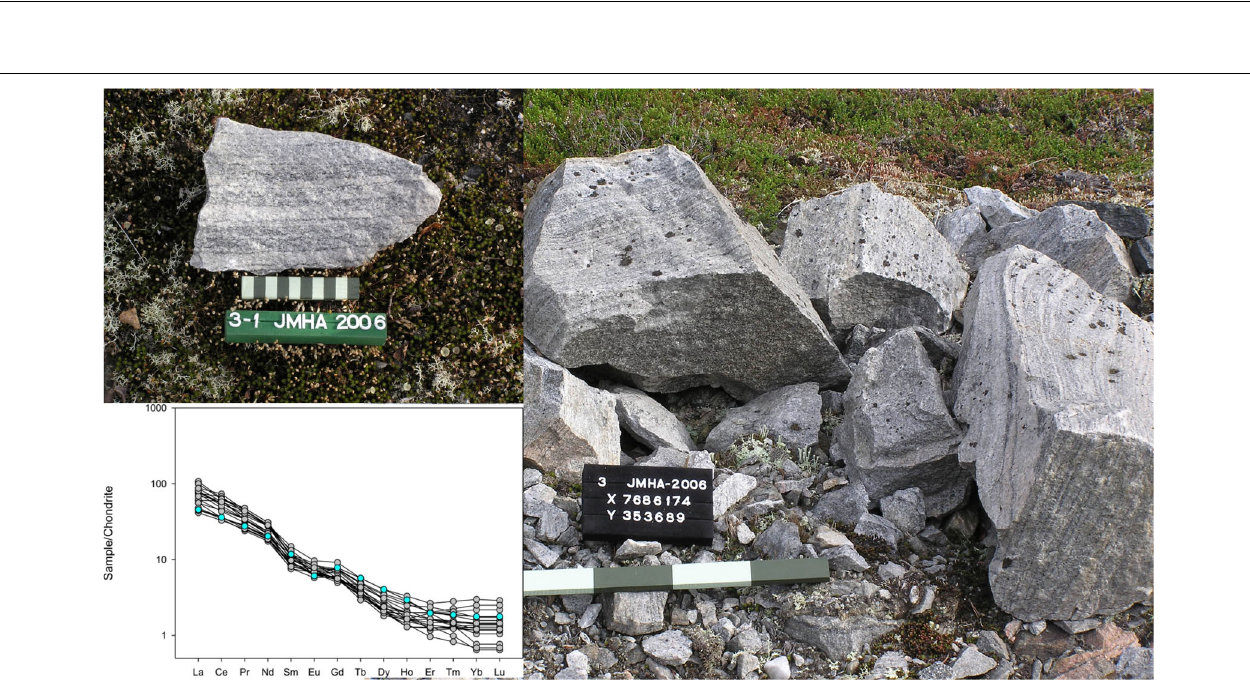
Frontiers in Earth Science |